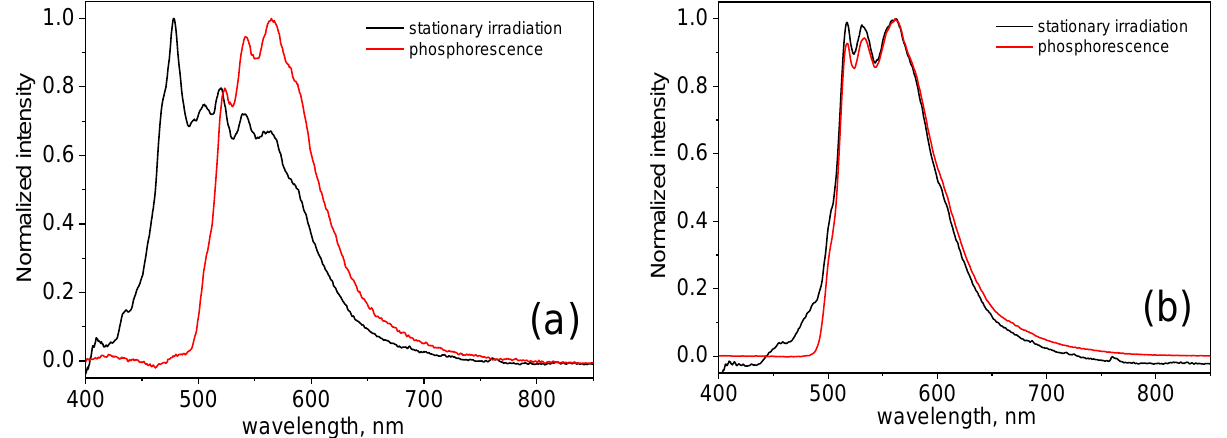
Figure 5. Low-temperature luminescence spectra for Phz1 ( a ) and Phz2 ( b ) under stationary light irradiation (black lines) and after turning off the excitation source (red lines).